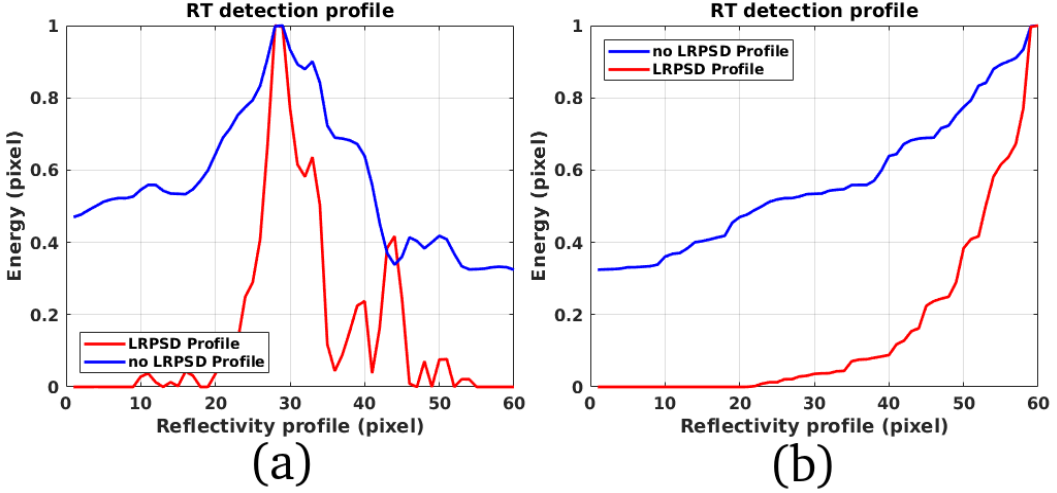
Figure 19. ( a ): Reflectivity profiles. ( b ): Receiving operating characteristic (ROC)